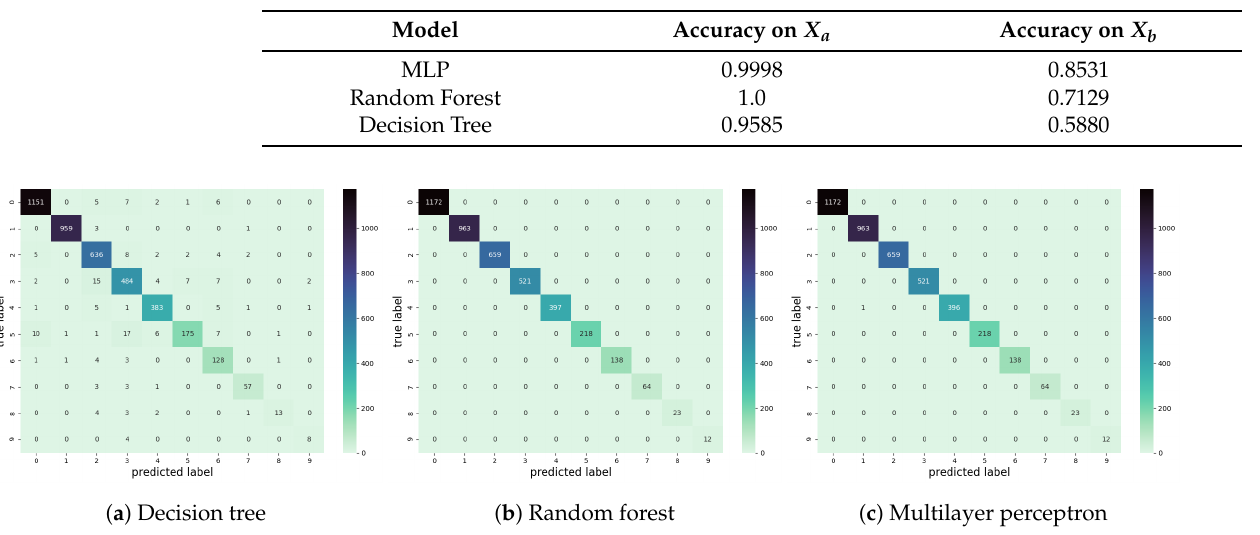
Table 4. Accuracies of three classification algorithms, on datasets X a and X b . All algorithms were trained on X a .